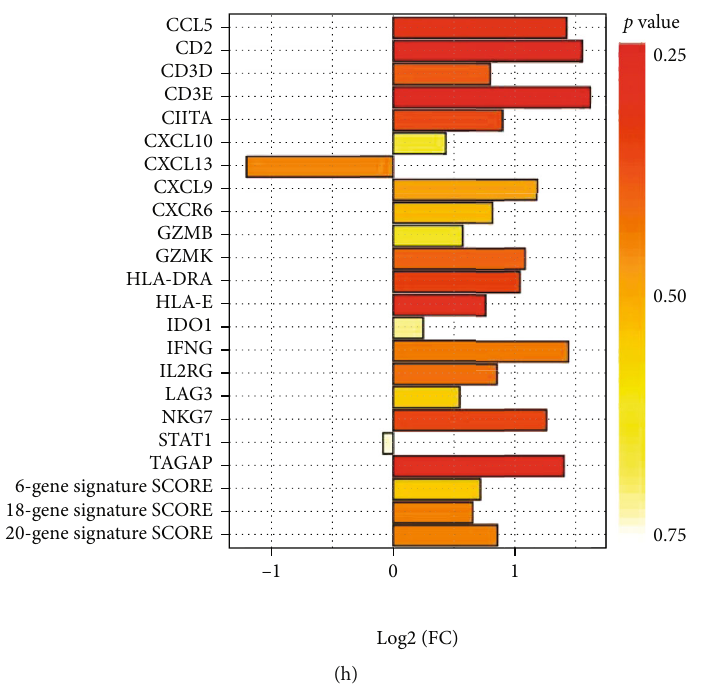
Figure 1: Transcriptomic signatures of bladder cancer in the immune microenvironment before and after neoadjuvant chemotherapy. (a) Heatmap showing the di ff erentially expressed genes in bladder cancer tissue samples. (b) Bar plot showing the di ff erentially expressed genes with signi fi cant fold changes. (c) Gene ontology (GO) analysis. (d) Kyoto Encyclopedia of Genes and Genomes (KEGG) analysis. (e) Hierarchical clustering heatmap showing the gene set variation analysis (GSVA) of gene signatures. (f) Bar plot showing immune in fi ltration genes analyzed by single-sample gene set enrichment analysis (ssGSEA). (g) Hierarchical clustering heatmap for innate anti- PD-1 resistance signature (IPRES). (h) Bar plot showing the score and fold change of T cell-in fl amed gene expression pro fi le (GEP). P value was calculated by the Wilcoxon rank-sum test or described in the panel. Di ff erences were found to be statistically signi fi cant at ∗ P < 0 : 05 and ∗∗ P < 0 : 01